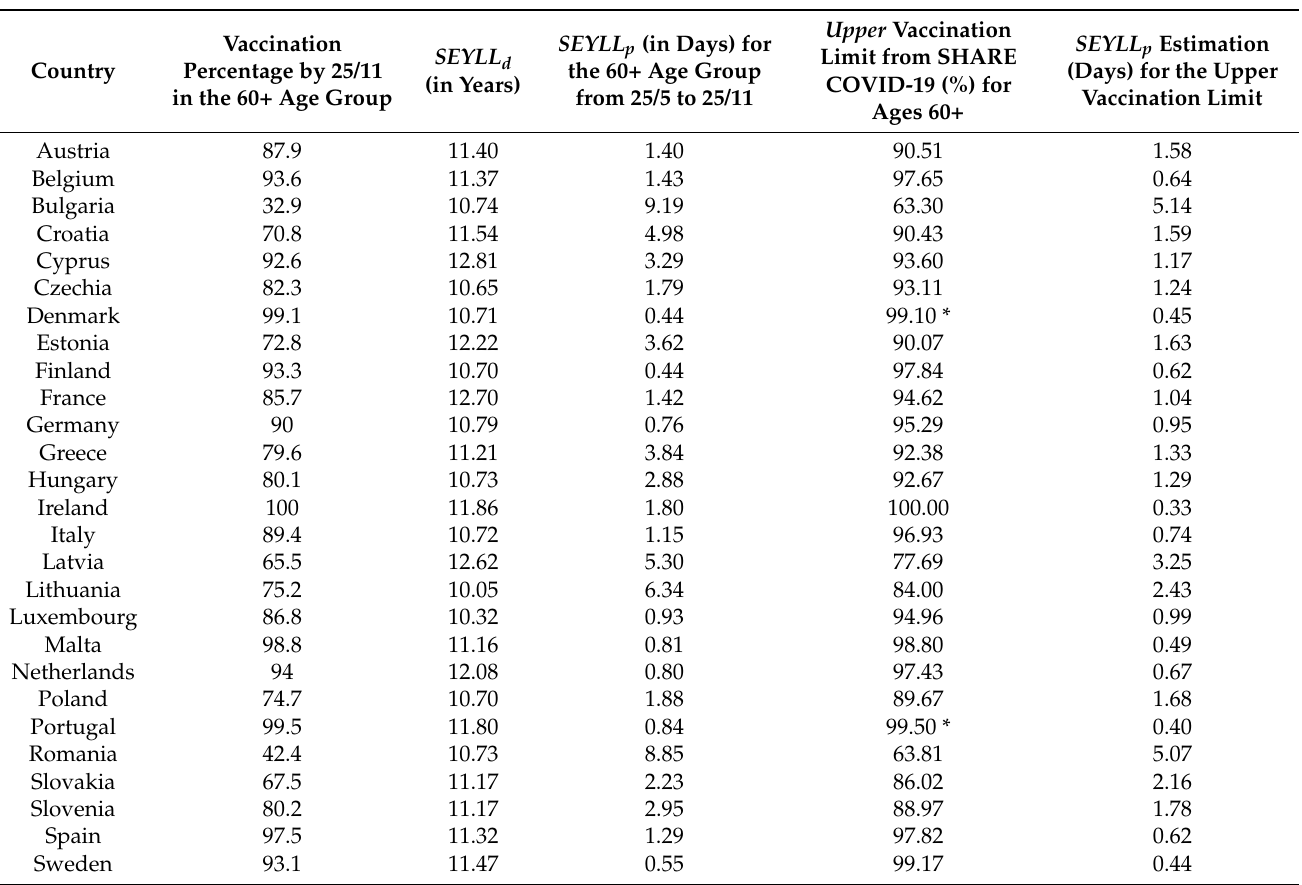
Table 2. Vaccination percentages by 25 November, SEYLL d in years, SEYLL p in days from 25 May to 25 November for the 60+ age group, upper vaccination limits for 60+ age group and estimated SEYLL p for the 27 EU countries.